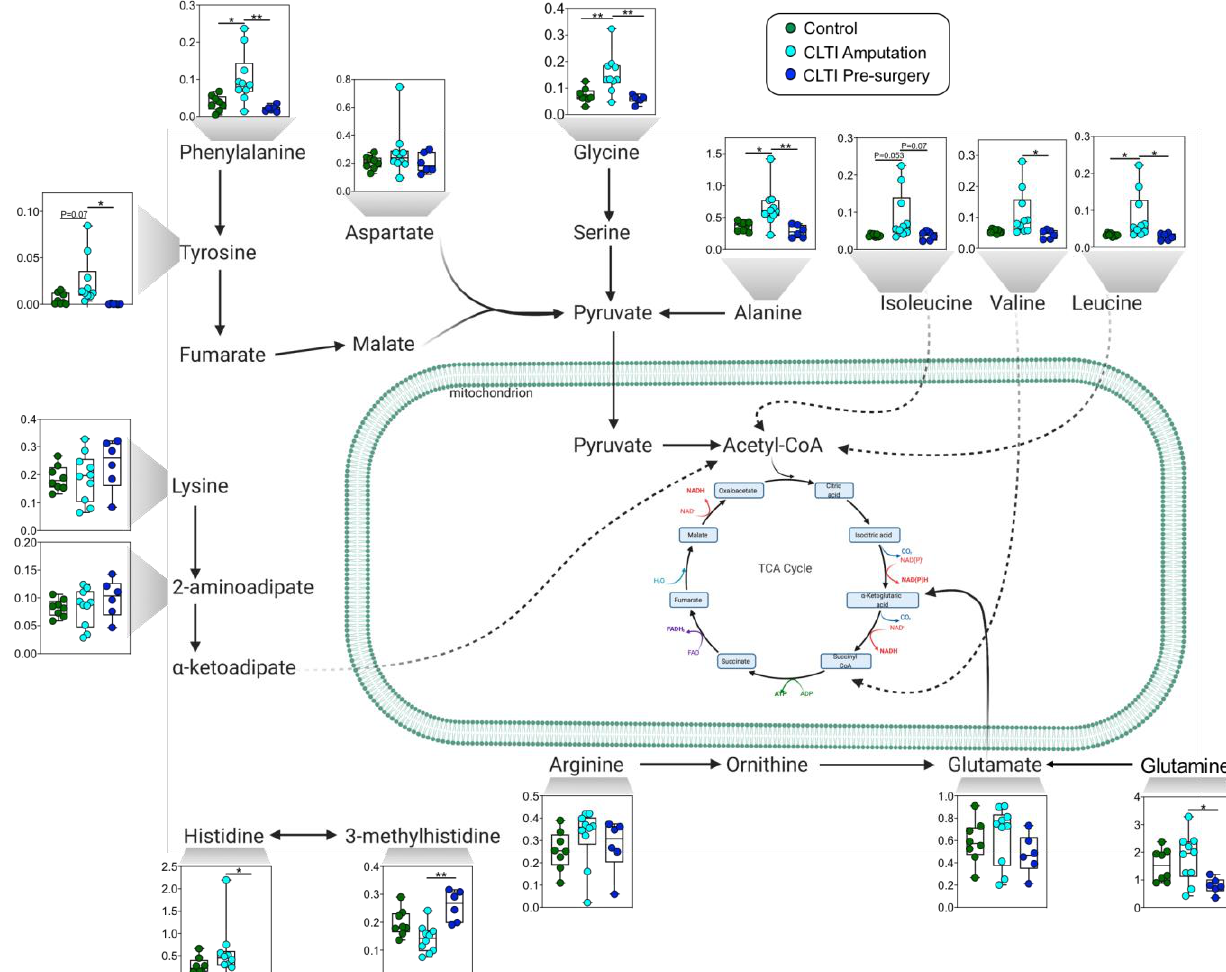
Figure 5. Dysregulated amino acid metabolism. Graphical depiction and quantitative analysis of amino acid concentrations in muscle specimens. Box and whisker plots with 95% confidence intervals are presented for quantified amino acids with concentrations in mM. Analysis was performed using one-way ANOVA with Tukey’s multiple comparisons test. * p < 0.05, ** p < 0.01.